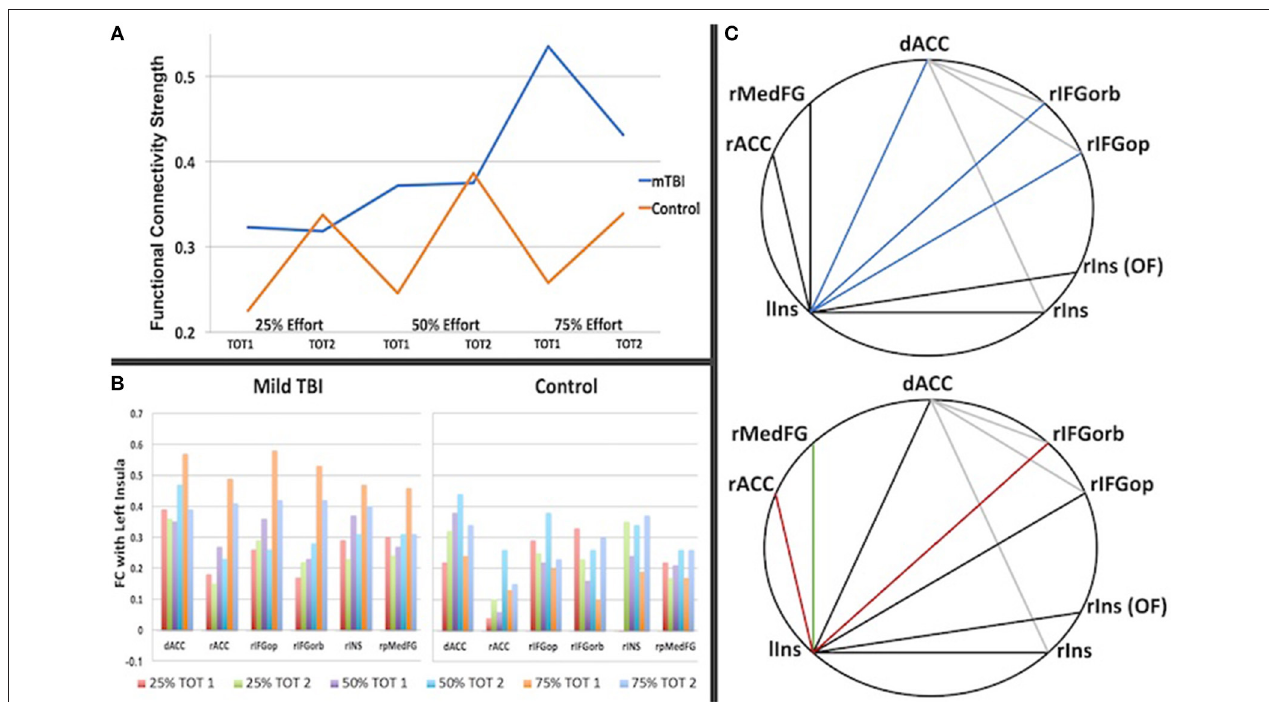
FIGURE 4 | The graph in (A) is a summary of the strength of connectivity across all region-to-region connections for Time on Task (TOT) in which there was a significant group difference (listed in Table 3 ). It illuminates the different patterns of connectivity change with effort and TOT, with the Control group showing an increase in connectivity strength in the second half of each trail at each effort level whereas the mTBI group does not show a TOT difference in functional connectivity strength at 25 or 50% but a steep increase in strength in the first half of each trail at 75% effort relative to the second half. In (B) , the differences are also evident by region in functional connectivity for the first half of the 75% -phase 1 condition (orange), particularly in the connections with other regions with the left insula. (C) Demonstrates the inter-regional connections that differed between the groups, with the darker lines representing connections with the left insula and colored lines indicated correlation of that connection with the trait (FSS, top) or state (CE Time Constant, bottom) measures of fatigue. ( C , top): Blue = connection correlates with the FSS for the first half of the 75% effort trials (left insula-dorsal ACC, rho = 0.28, p = 0.004; left inusula-right frontal orbitalis, rho = 0.25, p = 0.01, left insula-right frontal operculum, rho = 0.22, p = 0.027). ( C , bottom): Red = connection correlates with the CE Time Constant for the first half of the 75% effort level (left insula-rACC rho = − 0.35, p = 0.023 for all subjects; rho = − 0.41, p = 0.04 for mTBI group; left insula-right frontal orbitalis rho = − 0.57, p = 0.003 for mTBI group); Green = connection correlates with the CE Time Constant for the first half of the 75% effort level trials in the Control group (rho = − 0.58, p =